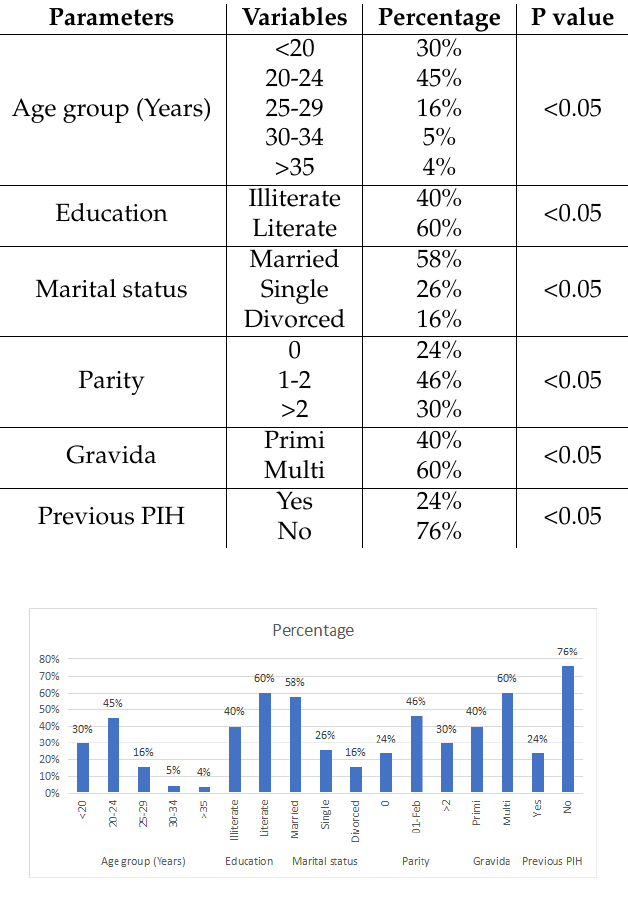
Figure 1. Parameters recorded in patients